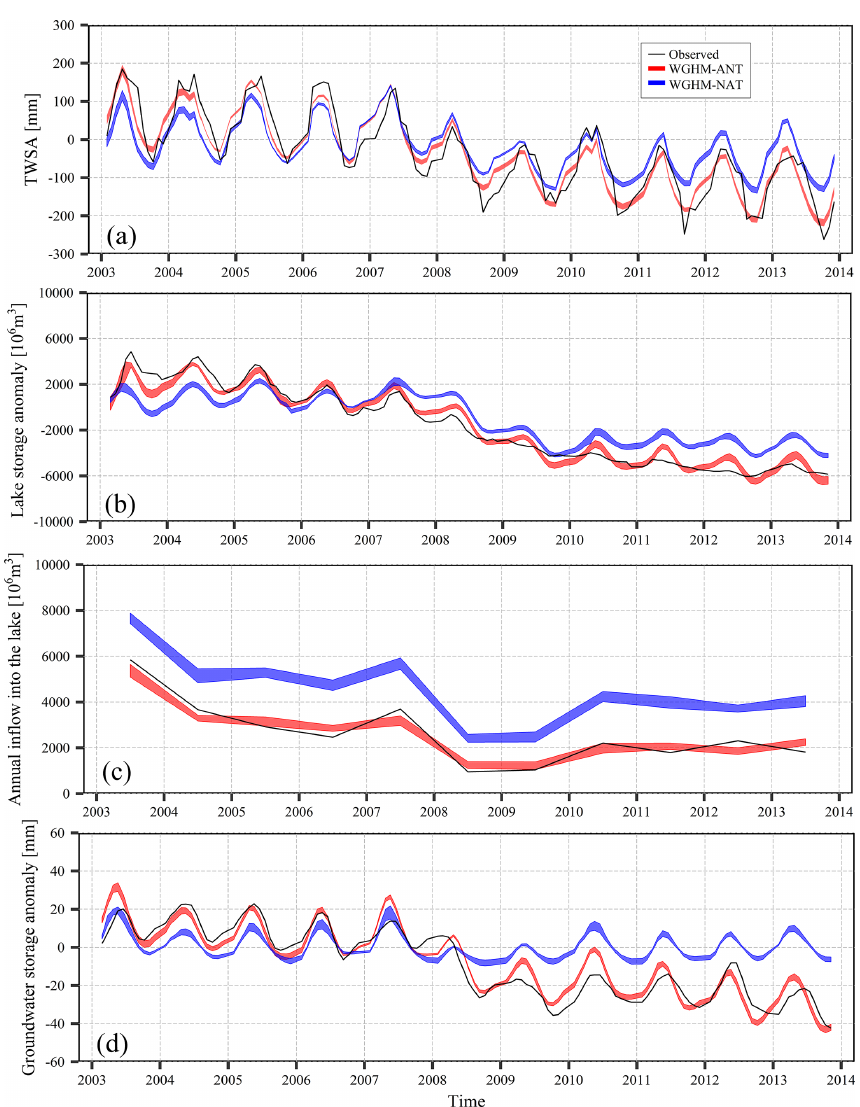
Figure 8. Time series of simulated (variant RS_Q_GW_NA) and observed monthly TWSA (a) , lake water storage anomaly (b) , annual inflow into the lake Q (c) , and monthly groundwater storage anomaly GWSA (d) , under anthropogenic (WGHM-ANT) and naturalized (WGHM- NAT)